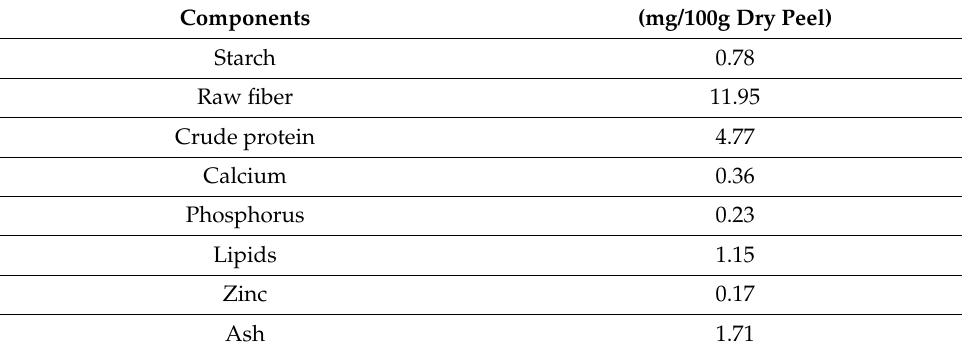
Table 3. Chemical composition of dry-based banana peel in solid state